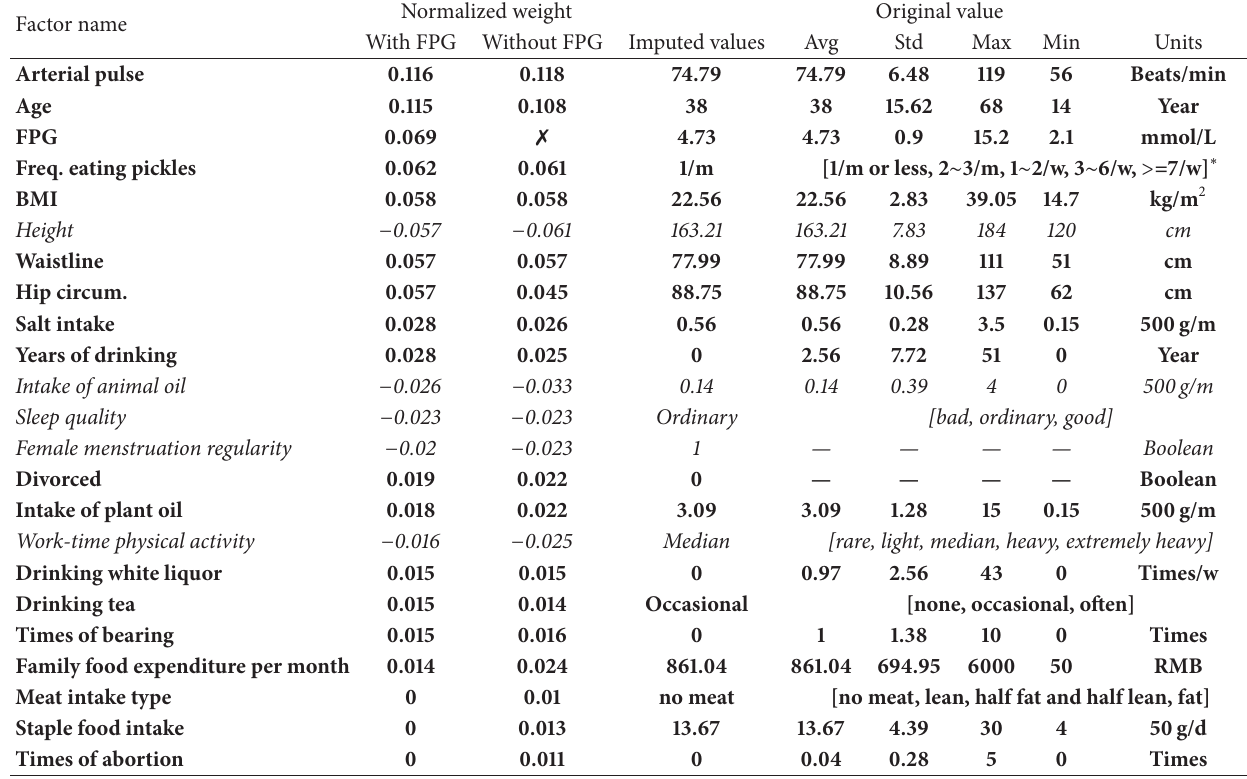
Table 2: Factors that affect HBP and their weights.